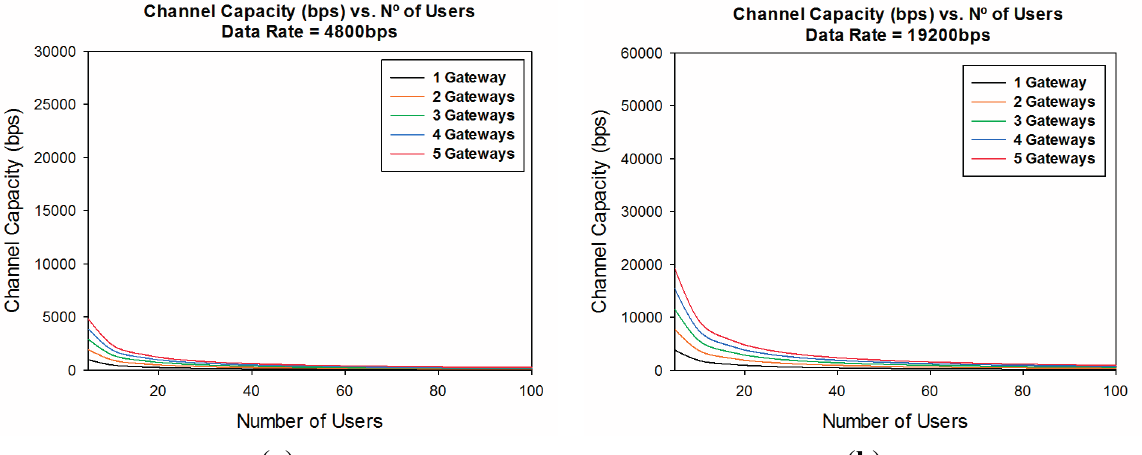
Figure 14. Channel capacity (bps) vs. the number of users for different number of gateways considered ( a ) Data Rate = 4800 bps; ( b ) Data Rate = 19,200 bps; ( c ) Data Rate = 57,600 bps; ( d ) Data Rate = 115,200